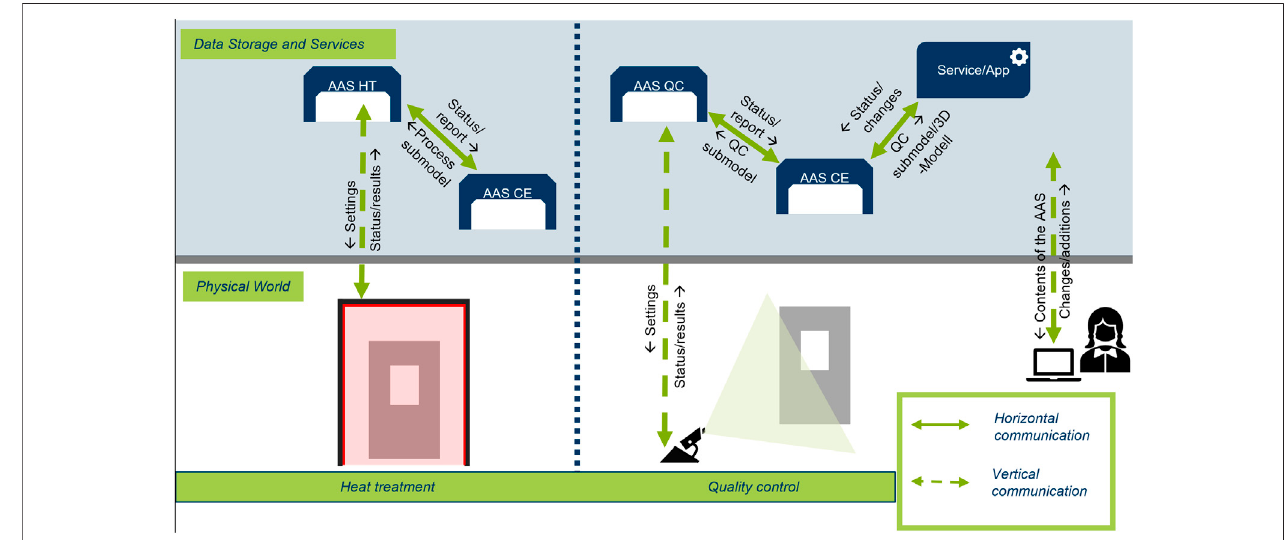
FIGURE 6 | Communication scheme using the example of the heat treatment and quality control process steps.